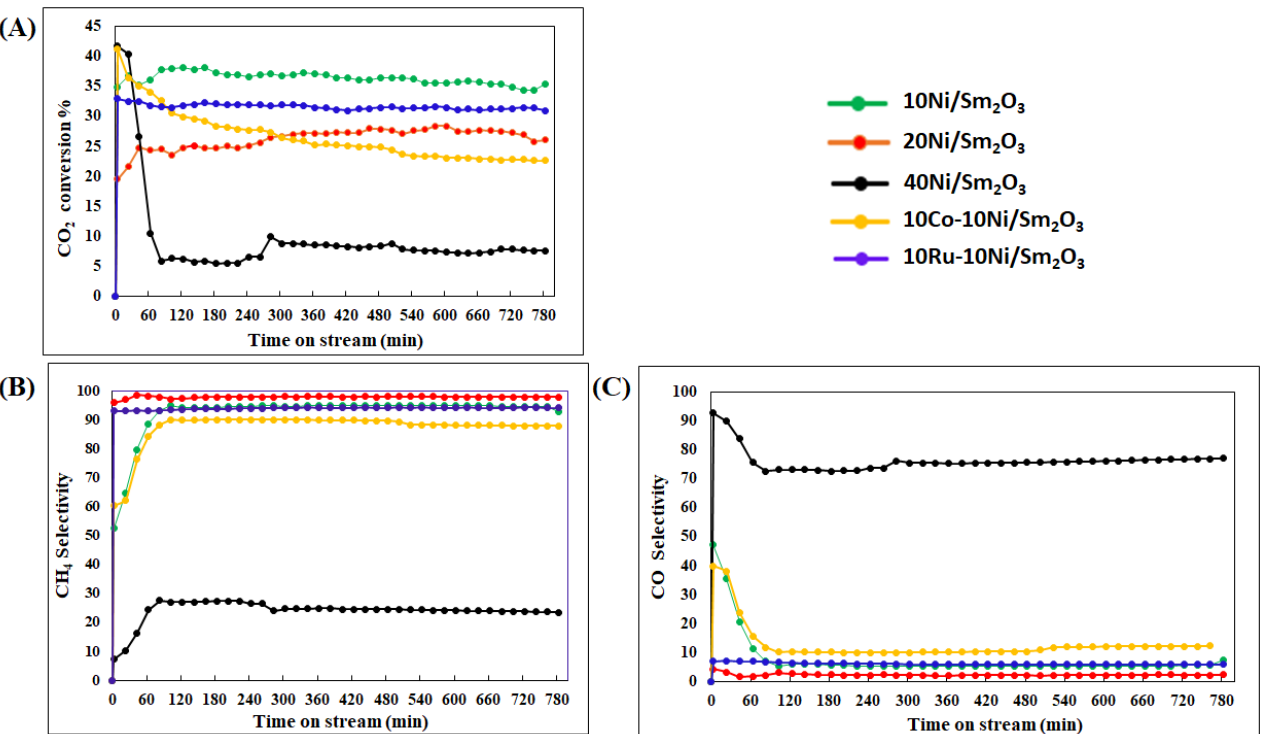
Figure 5. The catalytic activity Vs Time on stream of xNi/Sm 2 O 3 (x = 10, 20, 40) and M-Ni/Sm 2 O 3 (M = Co, Ru) catalysts at 350 °C reaction temperature over CO 2 :H 2 :Ar (1:4:5 volume ratio) feed gas: ( A ) CO 2 conversion Vs Time on stream ( B ) CH 4 selectivity Vs Time on stream ( C ) CO selectivity Vs Time on stream